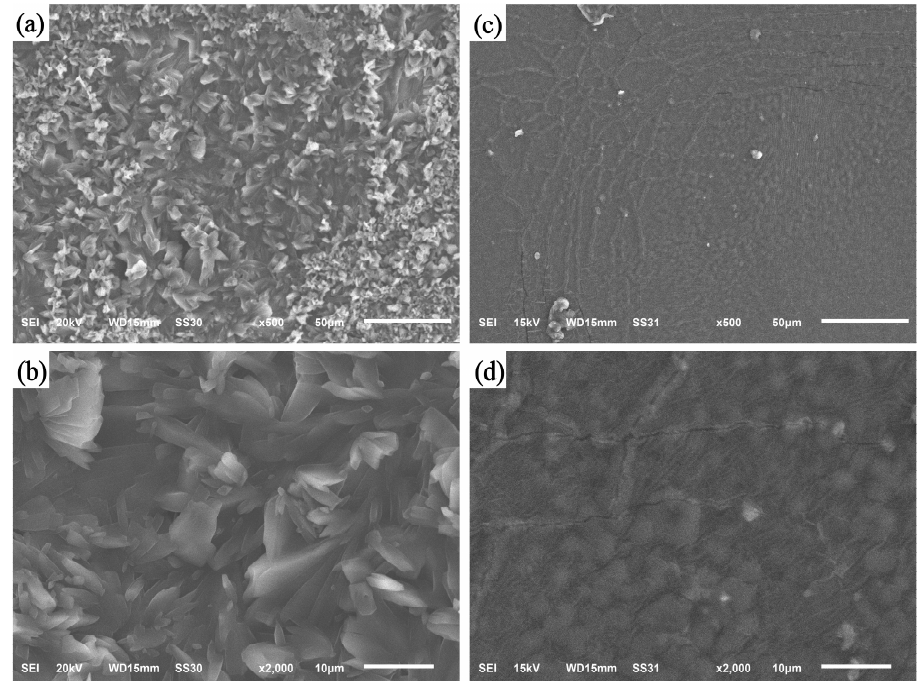
Figure 3. SEM images of CS membrane and CS/ β -CDP composite membrane: ( a ) 500 times before adsorption of BSA; ( b ) 2000 times before BSA adsorption; ( c ) 500 times after BSA adsorption; and ( d ) 2000 times after membrane adsorption of